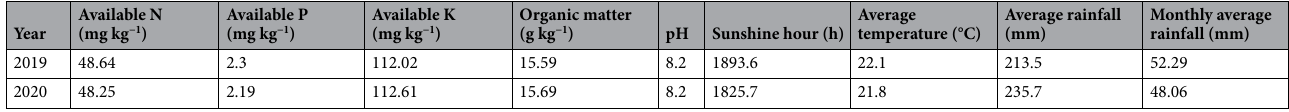
Table 1. Soil fertility and climatic